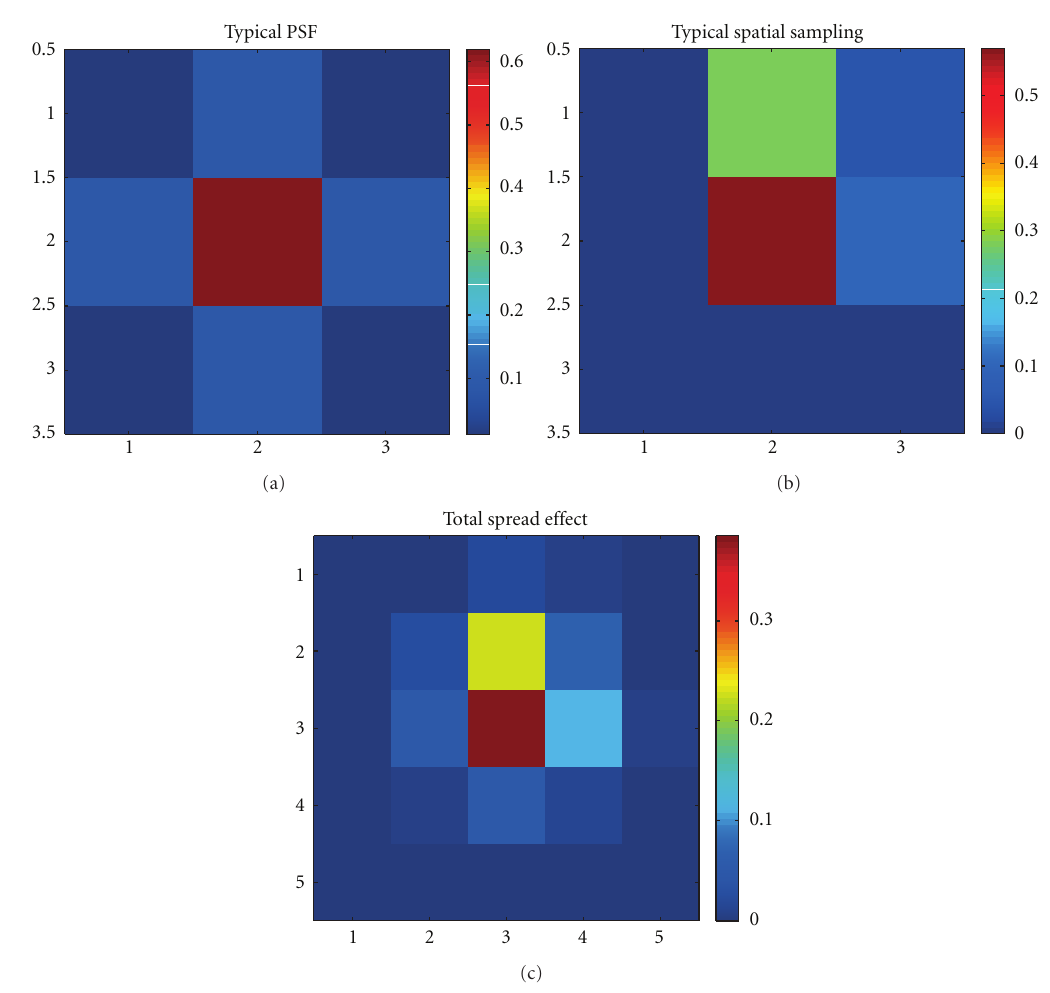
Figure 11: Synthetic spread